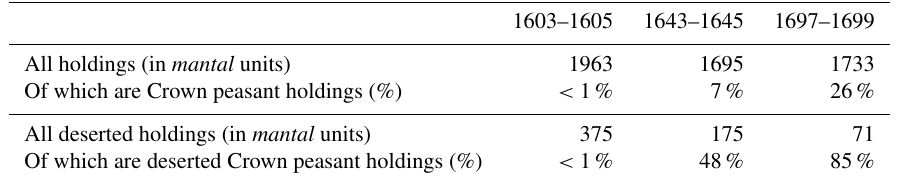
Table 1. Number of all holdings, the share of Crown peasant holdings in relation to all holdings, the number of all deserted holdings, and the share of deserted Crown peasant holdings in relation to all deserted holdings (all 3-year means) in the three southern parts of the study area (see Fig. 1, dashed lines). Note that data from the central and northern parts, which constituted ca. 80% of the land area and hold ca. 45% of the farmsteads of the province, are not included in the